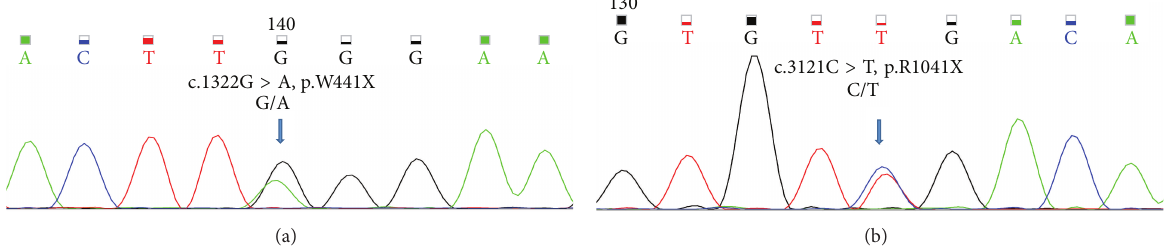
Figure 1: Sangers sequencing results of the SPG11 (NM 025137.3) variants identified by whole exome sequencing of the patient. (a) Showing the c.1322G > A mutation in exon 6 and (b) showing the c.3121C > T mutation in exon 17 of the SPG11 gene.